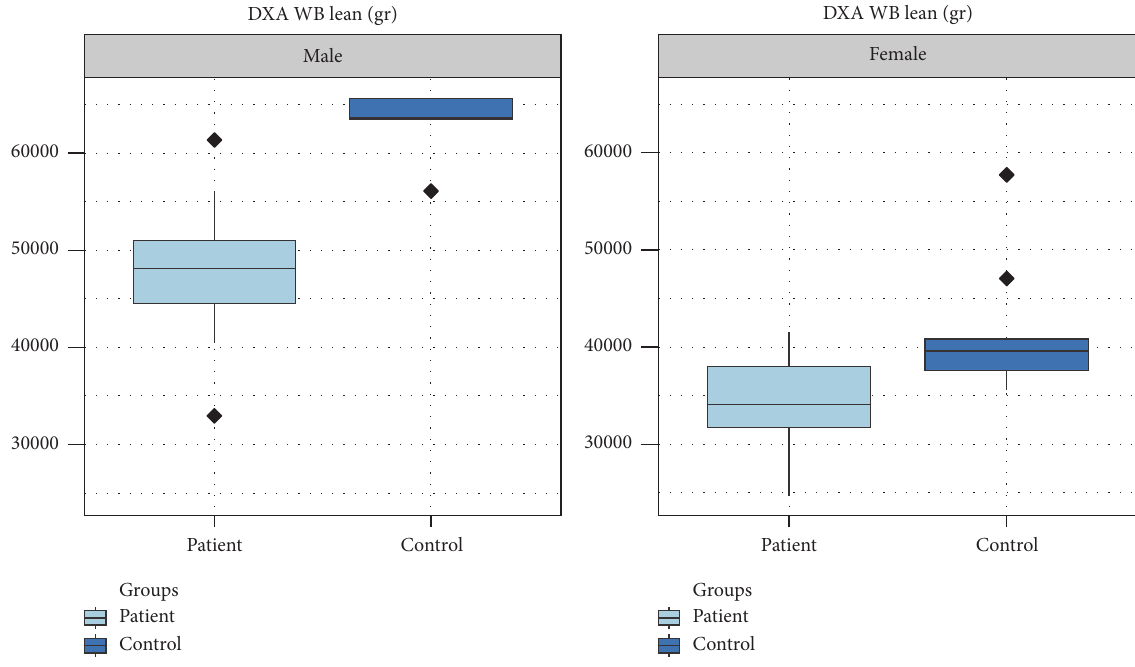
Figure 3: Lean mass of the whole body determined with DXA in male and female patients with thalassemia major compared with controls. Both male and female patients show a statistically significant reduction of the lean mass ( 𝑝 < 0.01 in both